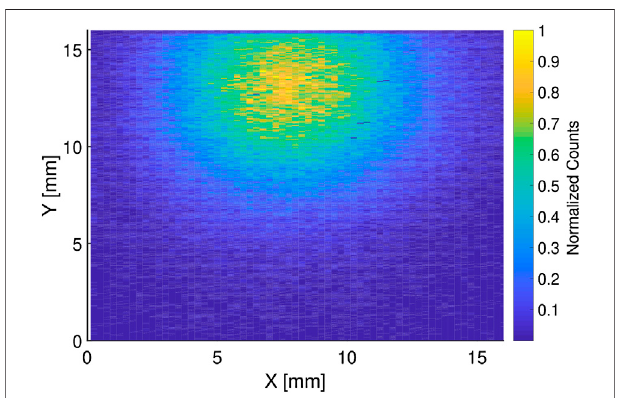
FIGURE 7 | MIP beam pro fi le acquired with the HVCMOS telescope described in [26].